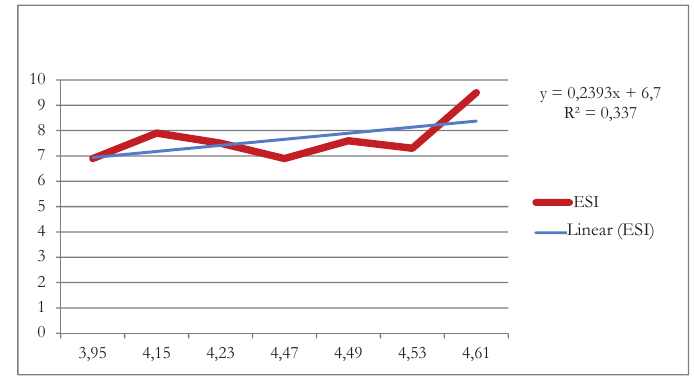
Fig. 8 – ESI in relation to APM. Source: